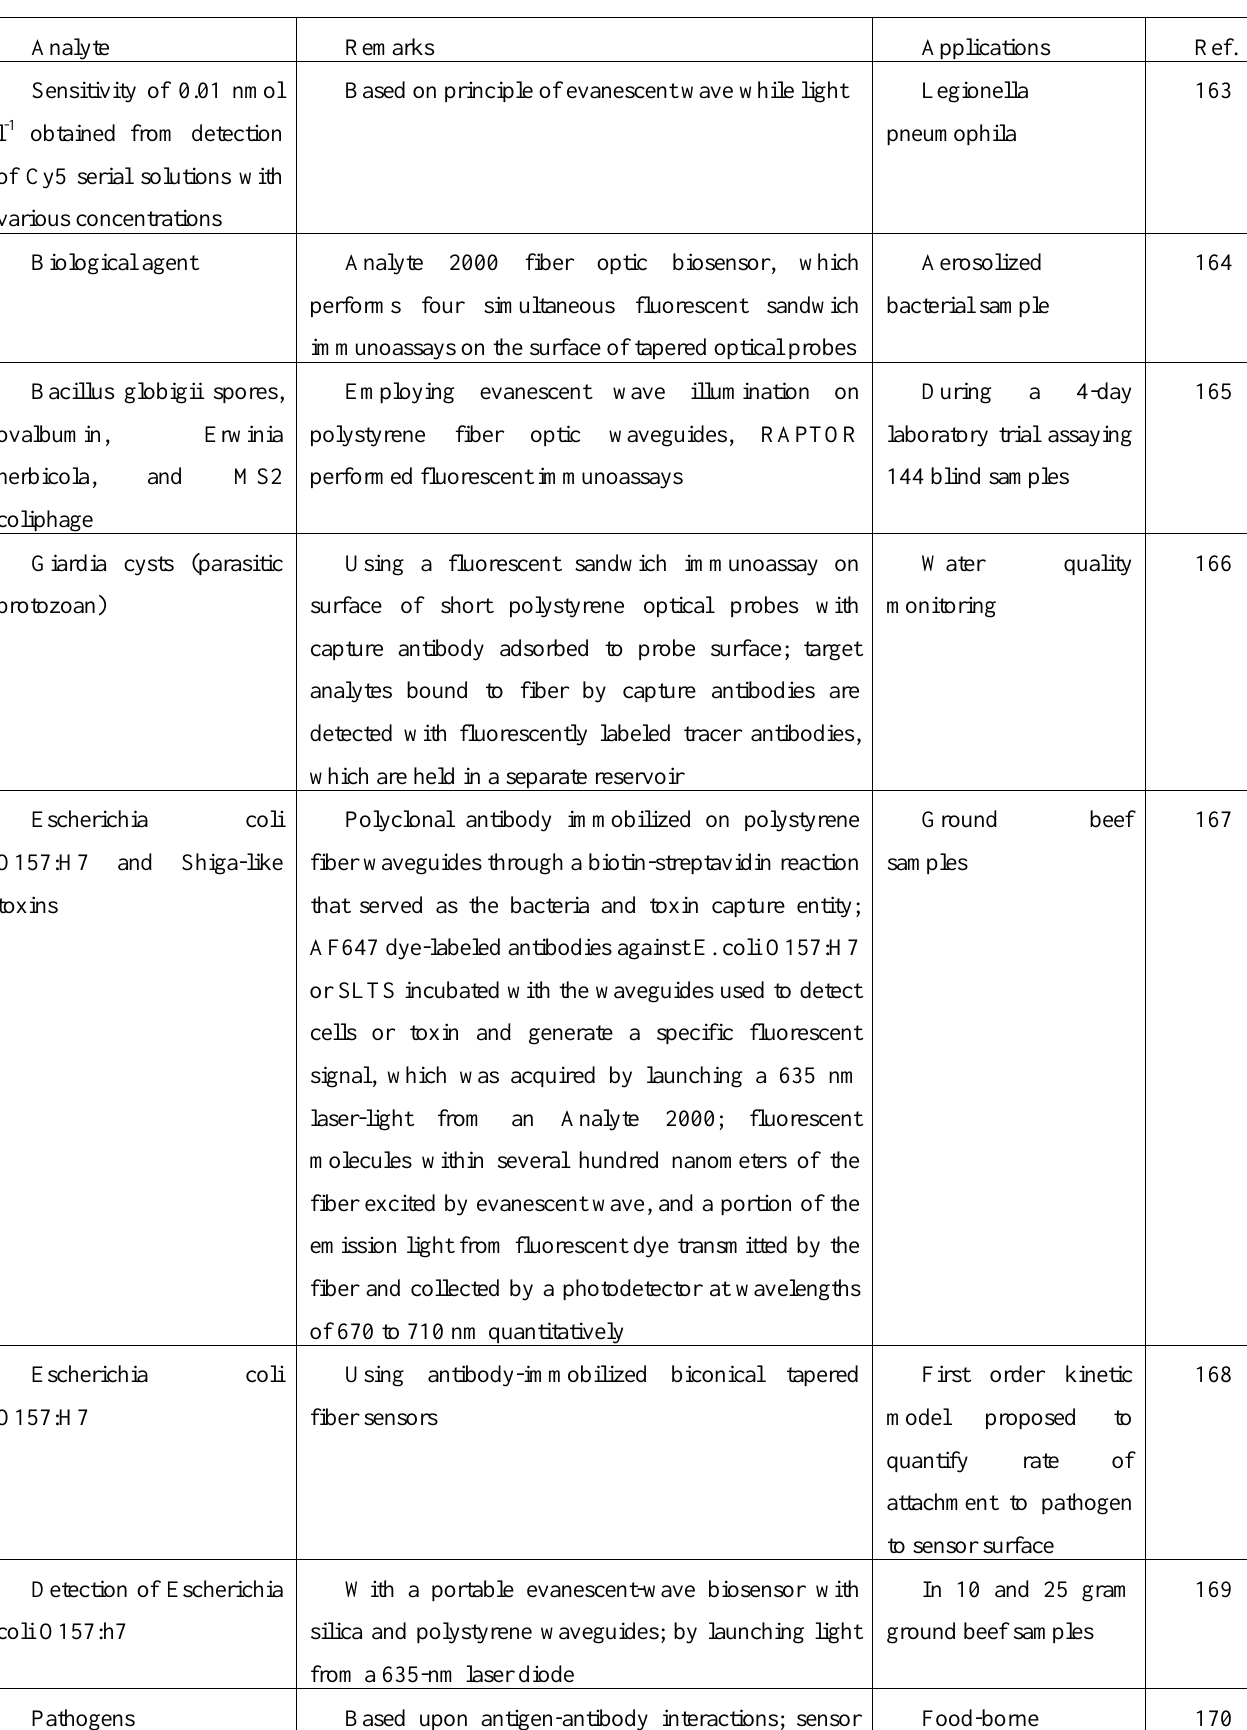
Table 2. Applications of fiber optic